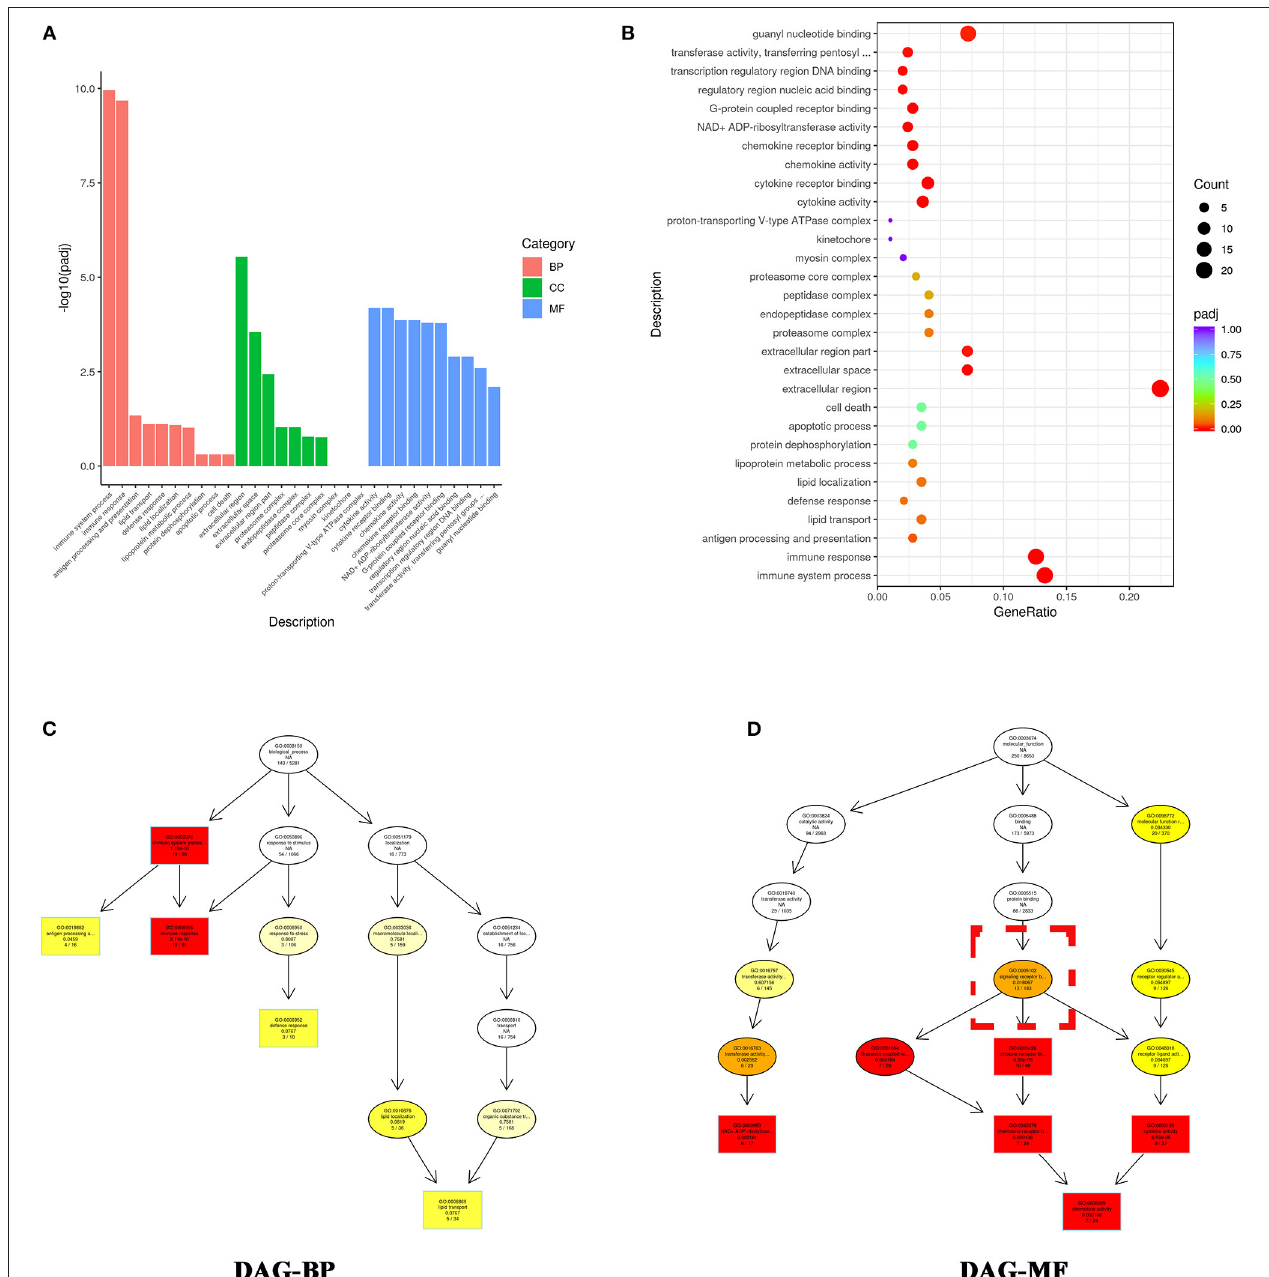
FIGURE 4 | GO enrichment analysis indicates that the differentially expressed genes altered by VO are primarily associated with immune response. (A) Histogram of the GO analysis. From the results of the GO enrichment analysis, we displayed the 10 most significant terms. The abscissa is the GO -term, and the ordinate is the significance level for GO term enrichment; the higher the value, the more significant the result. The different colors represent three different GO subclasses: biological process (BP), cellular component (CC), and molecular function (MF). (B) Scatter plots of GO analysis. From the results of the GO-enrichment analysis, we selected the 30 most significant terms to construct scatter plots for display. The size of the dots represents the number of genes annotated to the GO term, and the colors from red to purple represent the significance level of the GO term enrichment. (C) DAG analysis of biological process (BP). (D) DAG analysis of molecular function (MF). The intensity of the color represents the degree of enrichment; a darker color indicates a higher degree of enrichment. Each node displays the name of the term and the adjusted P -value